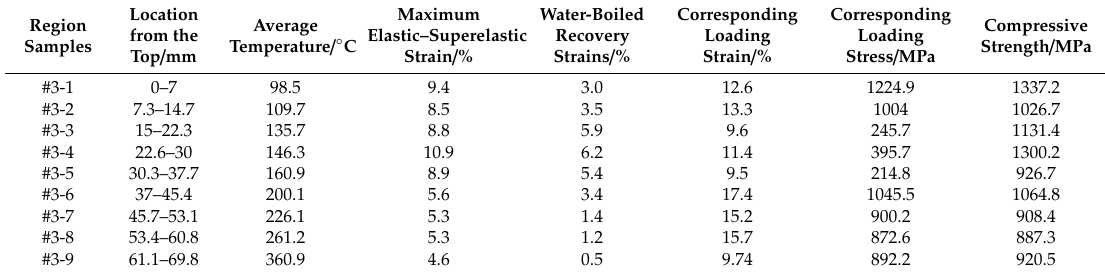
Figure 7. ( a ) Relationship between elastic–superelastic strain and loading strain and ( b ) relationship between loading stress and loading strain in different regions of sample #3. Table 1. Maximum elastic–superelastic strain and corresponding loading strain and stress in different regions of the #3 sample.